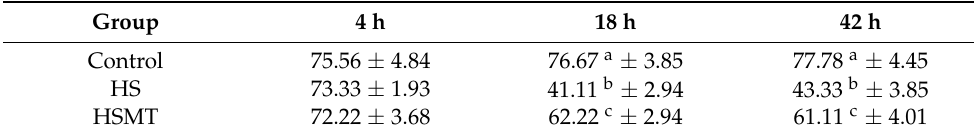
Figure 1. Effect of heat stress (HS) and melatonin on the normal rate of α -tubulin in the porcine oocytes during in vitro maturation (IVM). DNA (blue) is stained by Hoechst 33342, and α -tubulin (red) is stained using an anti- α -tubulin antibody. ( A ): normal α -tubulin and DNA in the oocytes during IVM at 4, 18 and 42 h, respectively. ( B ): abnormal α -tubulin and DNA in the oocytes during IVM ( a , b for 4 h; c – f for 18 h; g and h for 42 h). Bar = 20 µ m. Table 3. Normal rate of α -tubulin